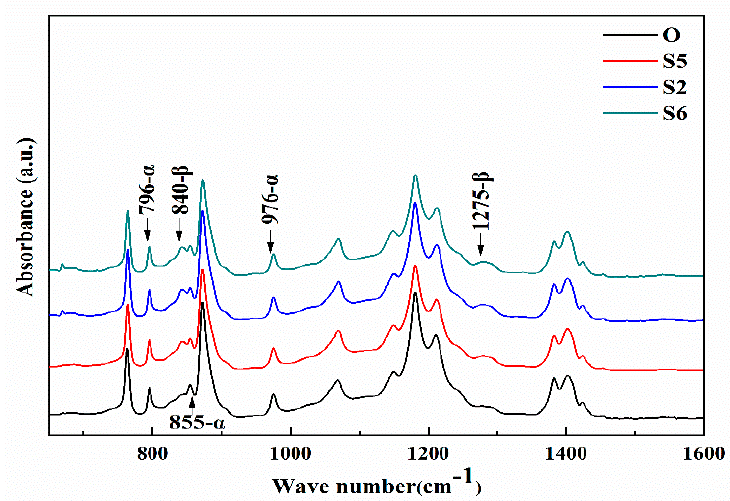
Figure 6. The ATR-FTIR spectra of the membrane samples stretched with different stretching rates.